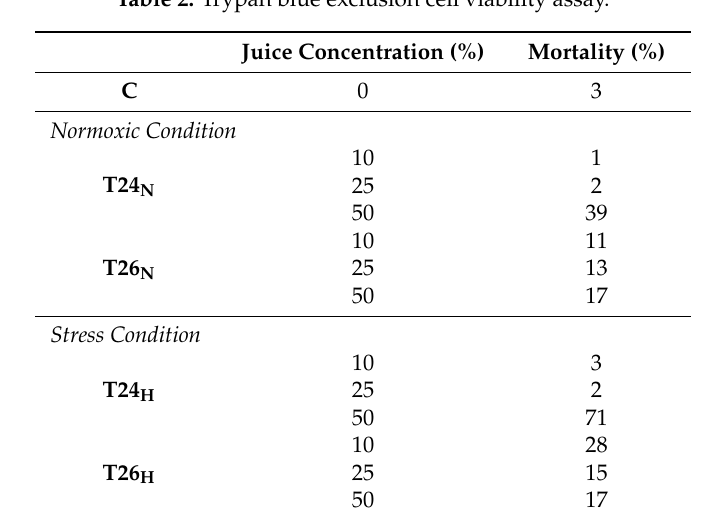
Table 2. Trypan blue exclusion cell viability